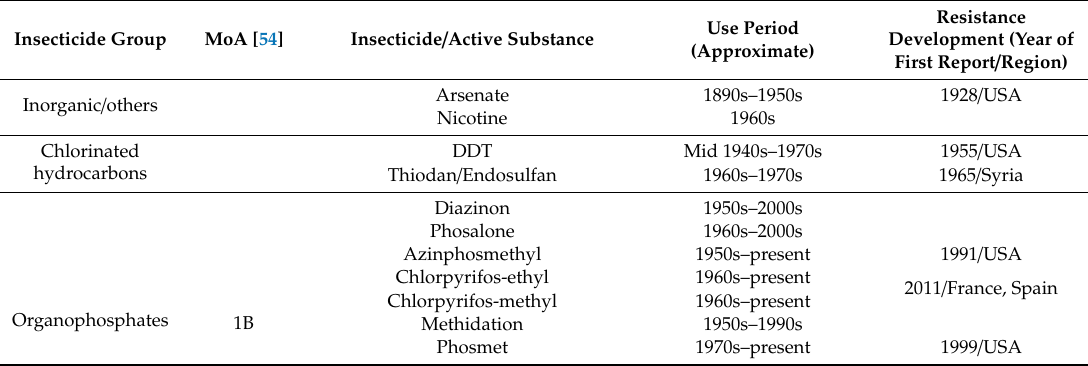
Table 1. Review of registered insecticides to suppress codling moth from 1890–current [54,55] and time of resistance development according to the Arthropod Pesticide Resistance Database